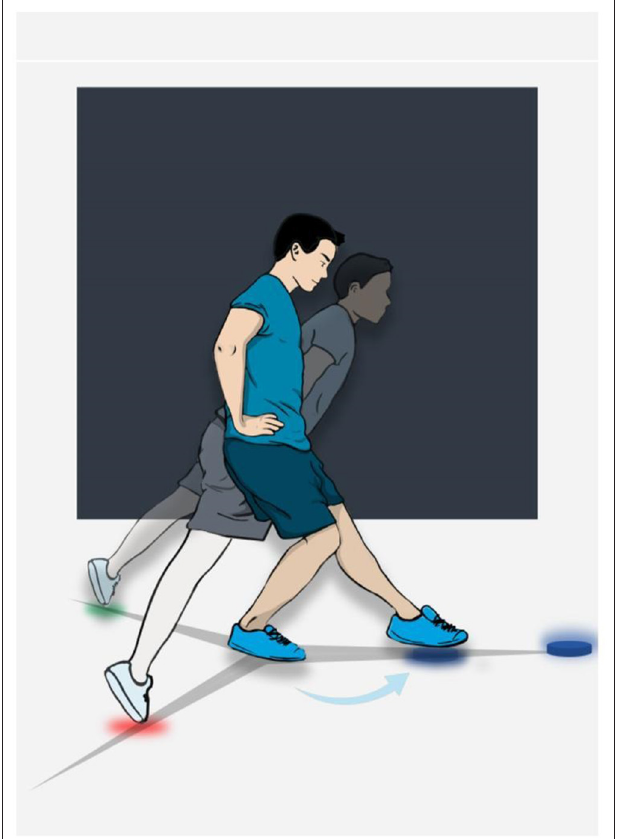
FIGURE 8 | Example of neurocognitive testing (reactive balance test). In this figure, the color blue is shown and the participant then has to decide which of the three LED-lights (red, green or blue) need to be extinguished. The participant correctly turns off the blue light on the anterior axis in this